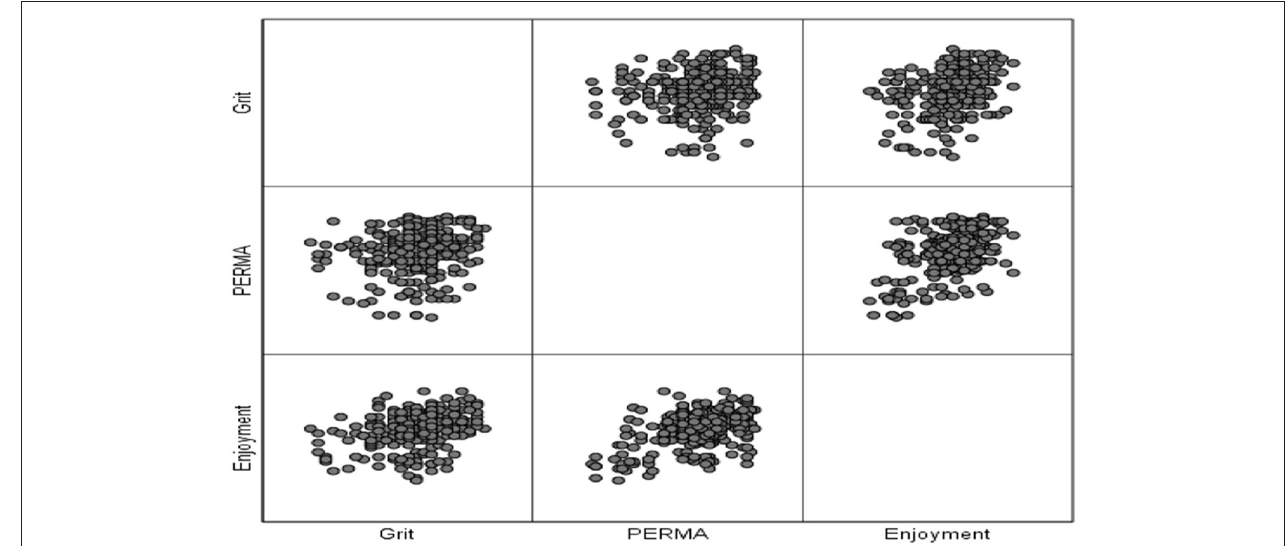
FIGURE 1 | Multiple scatterplot of the relationships between variables.